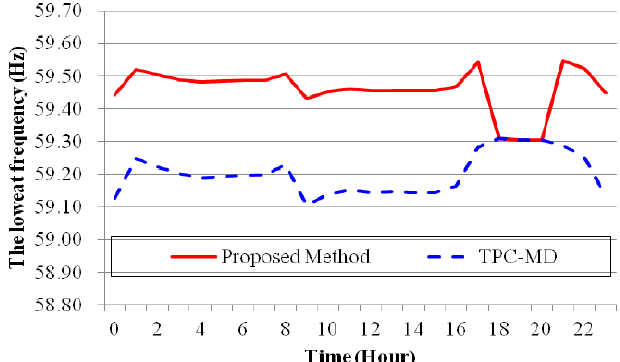
Figure 3. The lowest frequency following the largest on-line generator outage on weekend comparison between the proposed method and TPC-MD.